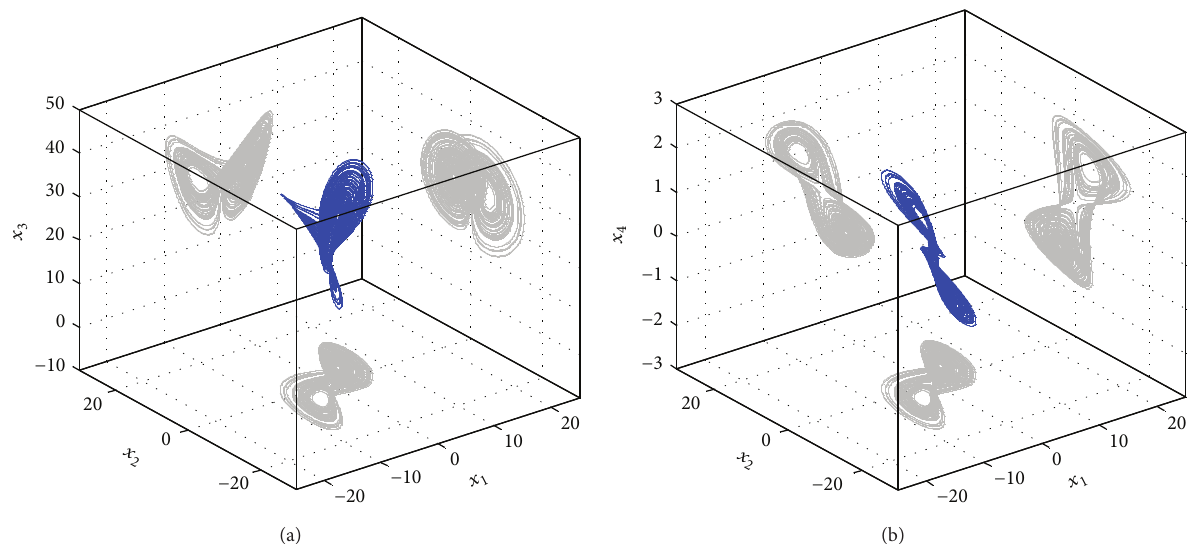
Figure 1: Three-dimension phase portrait of the four-dimensional Lorenz-Stenflo system and its projection.